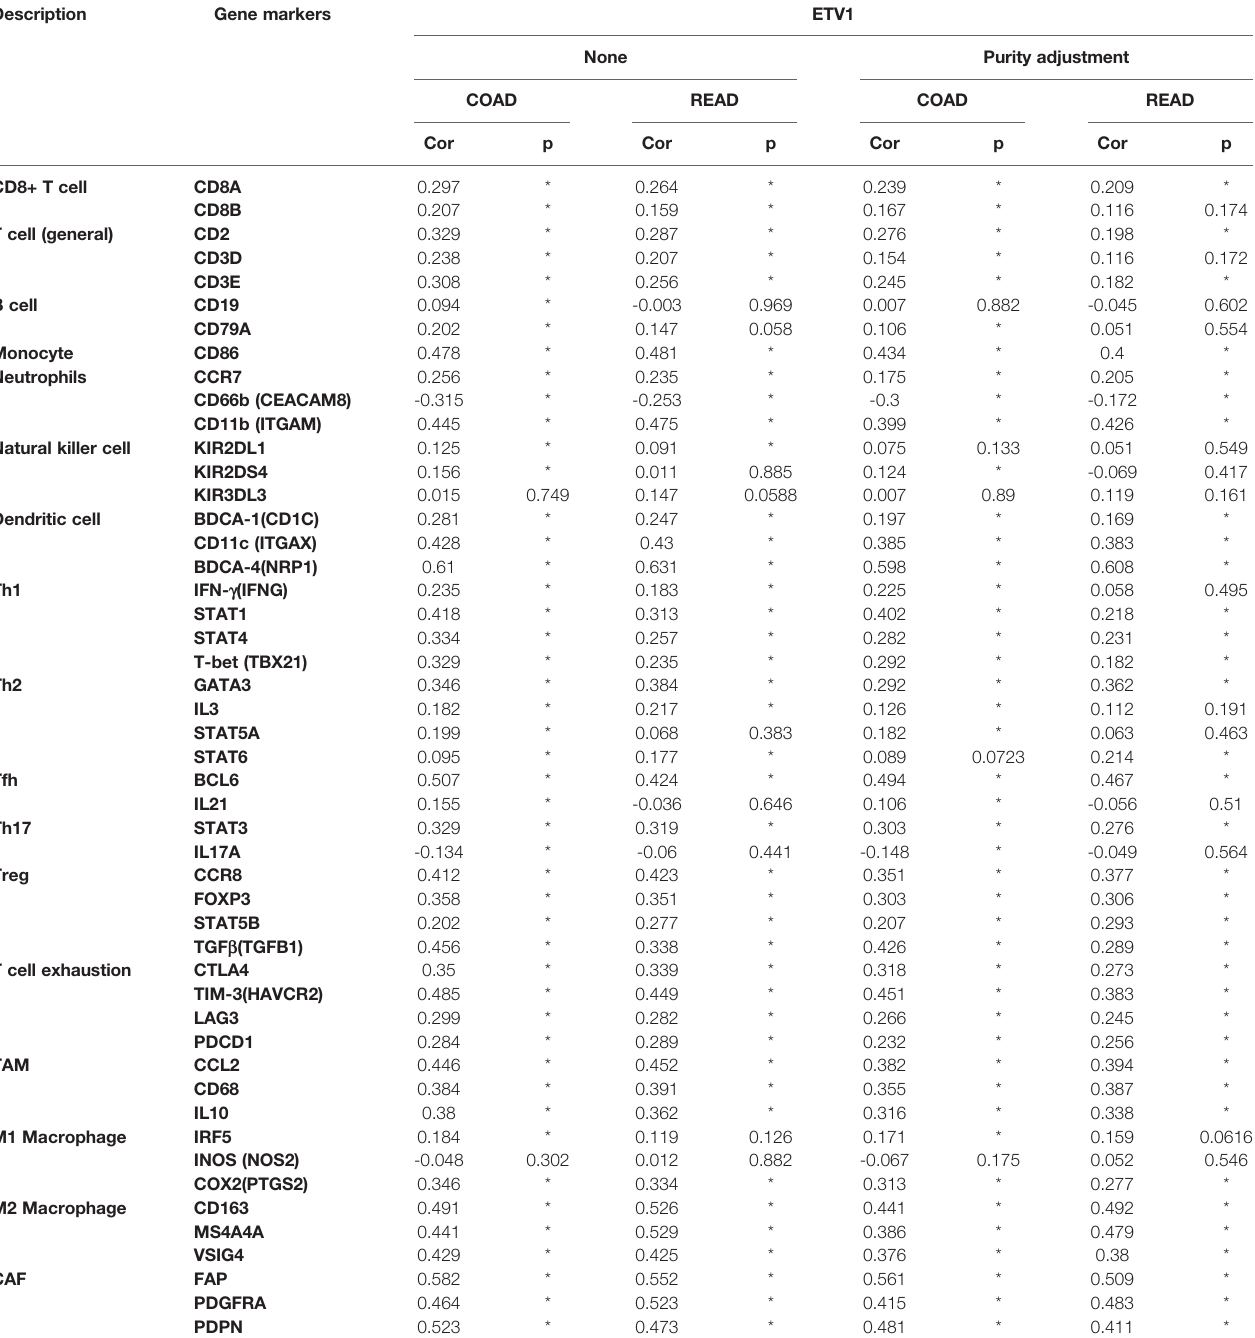
TABLE 3 | Correlation analysis among ETV1 and related gene markers of immune cells in TIMER. Description Gene